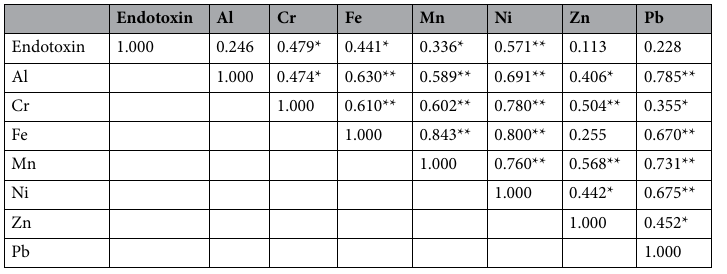
Table 4. Correlation analysis between levels of endotoxins, Al, Cr, Fe, Mn, Ni, Zn, and Pb. * p < 0.05; ** p <